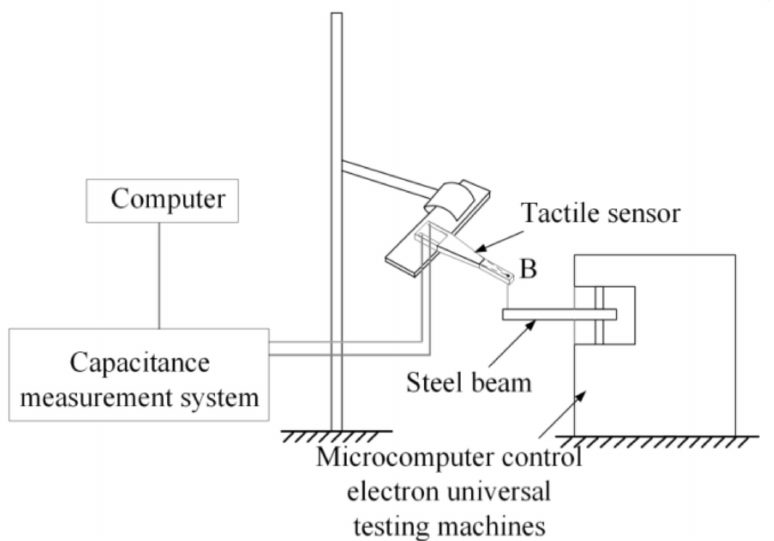
Figure 7. Schematic diagram of experimental setup for the displacement sensing analysis.